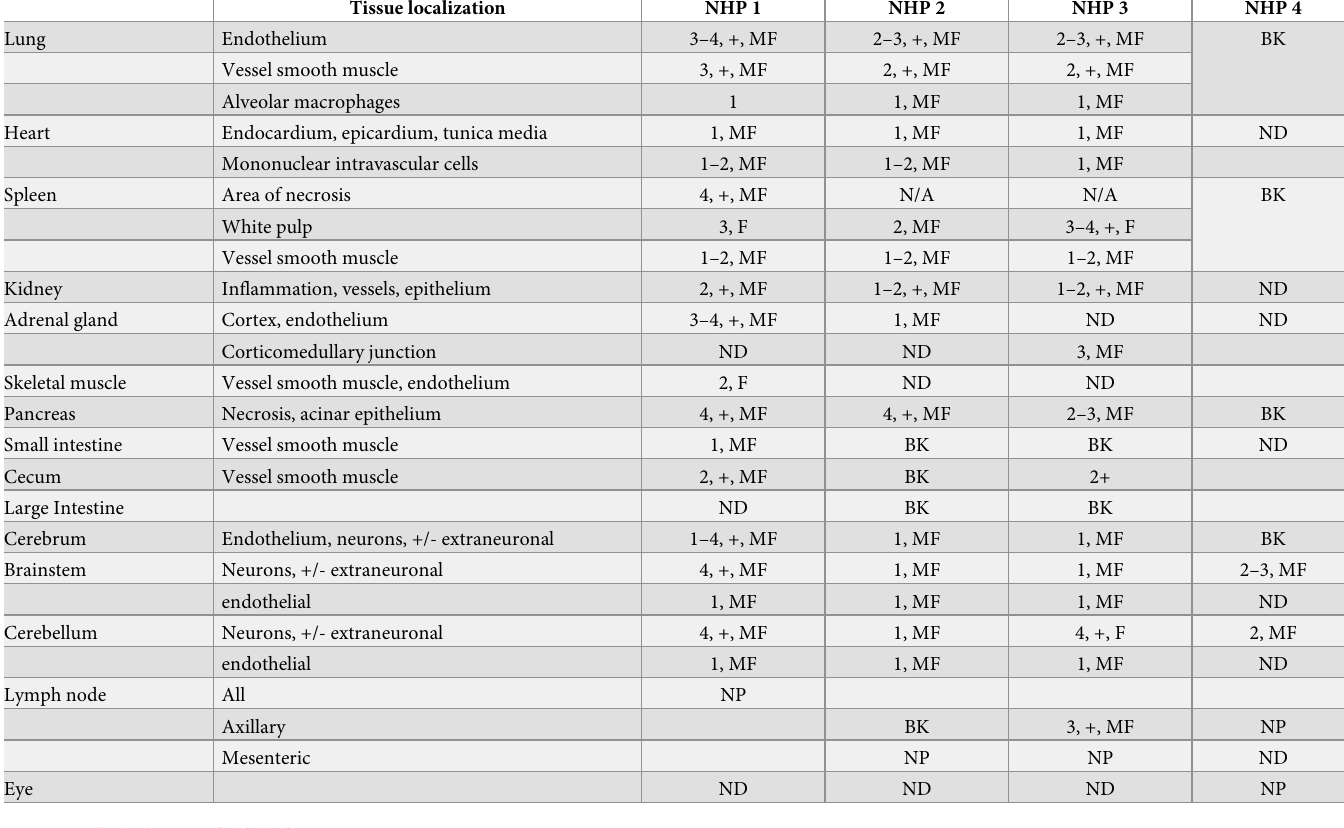
Table 2. Immunohistochemistry